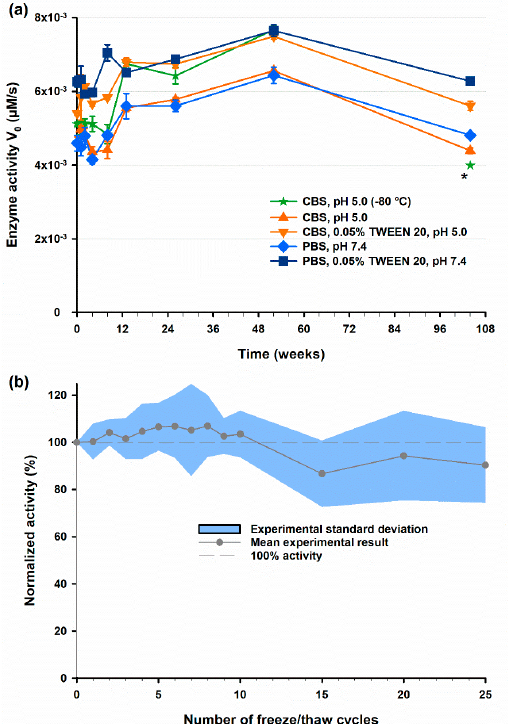
Figure 8. ( a ) long-term storage stability of T7AC-cpCasp2, as determined by FRET assay. Different formulations were stored at –20 °C and compared to a control sample stored at –80 °C. Error bars are experimental standard deviation ( n = 3). *For the 104-week data point of CBS, pH 5.0 (–80 °C) a different production lot of T7AC-cpCasp2 with a slightly lower base activity had to be used; ( b ) enzymatic activity over 25 freeze/thaw cycles. T7AC-cpCasp2 was repeatedly frozen at –20 °C and thawed. Enzymatic activity was determined by FRET assay. The blue area denotes the standard deviation of the experiment ( n = 9). No significant activity decrease could be detected after 25 freeze / thaw